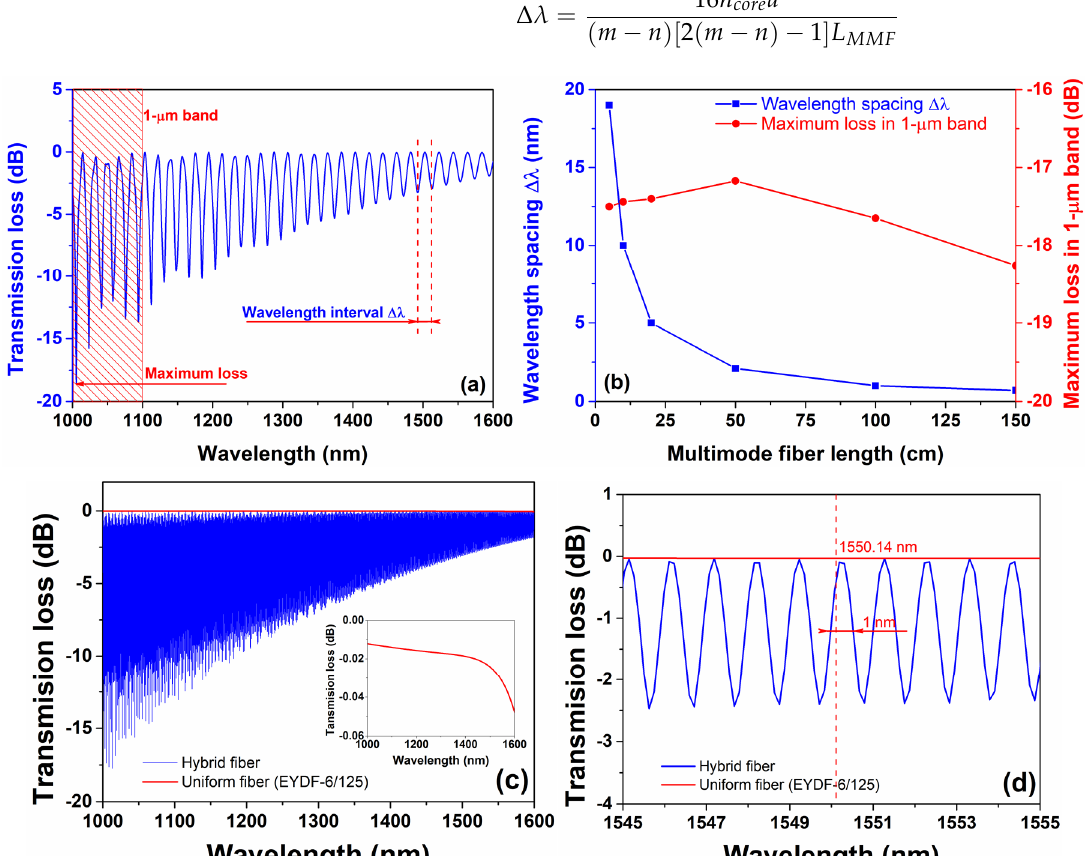
Figure 2. ( a ) The transmission spectrum of the active SMS with 5-cm multimode fiber; ( b ) the maximum loss in the 1-μm band and wavelength spacing with variation in multimode fiber length; ( c ) the transmission spectrum of the active SMS with 1-m multimode fiber. (Inset) the transmission loss of a uniform EYDF-6/125 fiber; ( d ) the zoomed transmission spectrum in the range of 1545~1555 nm.